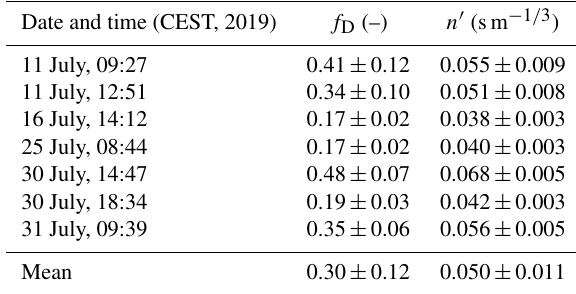
Table 3. The Darcy–Weisbach friction factor f D and Manning roughness n (cid:48) with associated standard deviation in the channel seg- ment between stations P5 and P3. All measurements were per- formed during Phase I of the drainage when salt dilution experi- ments were conducted (see Fig.